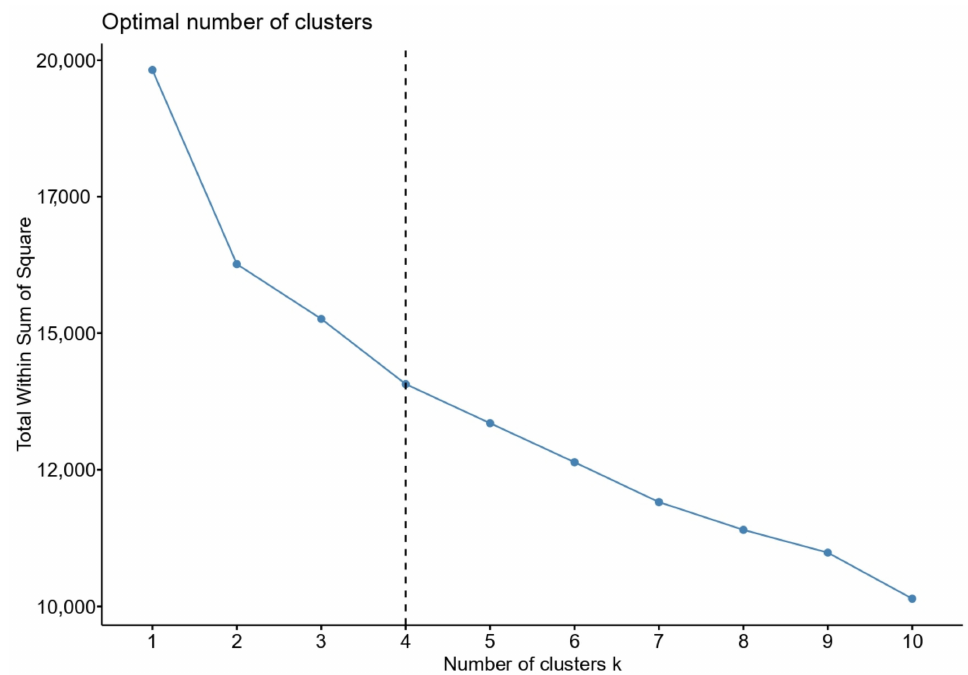
Figure 2. Within-cluster sum of squares to determine the optimal number of